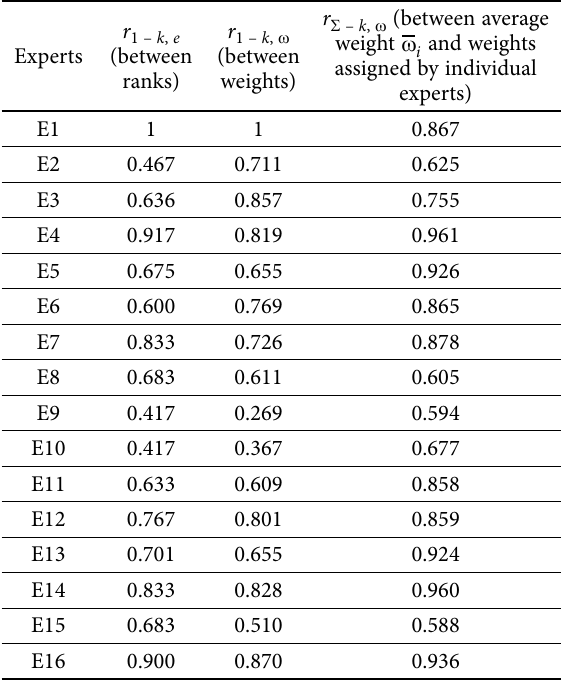
Table 7. The estimates of the values of correlation